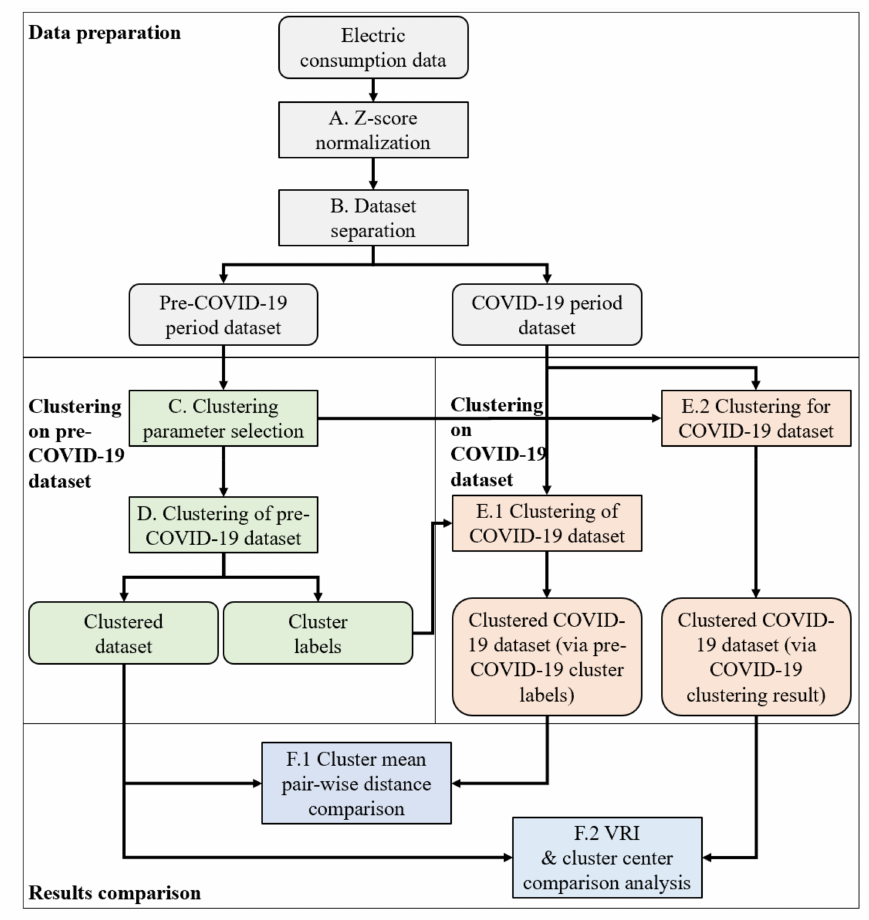
Figure 2. Analysis